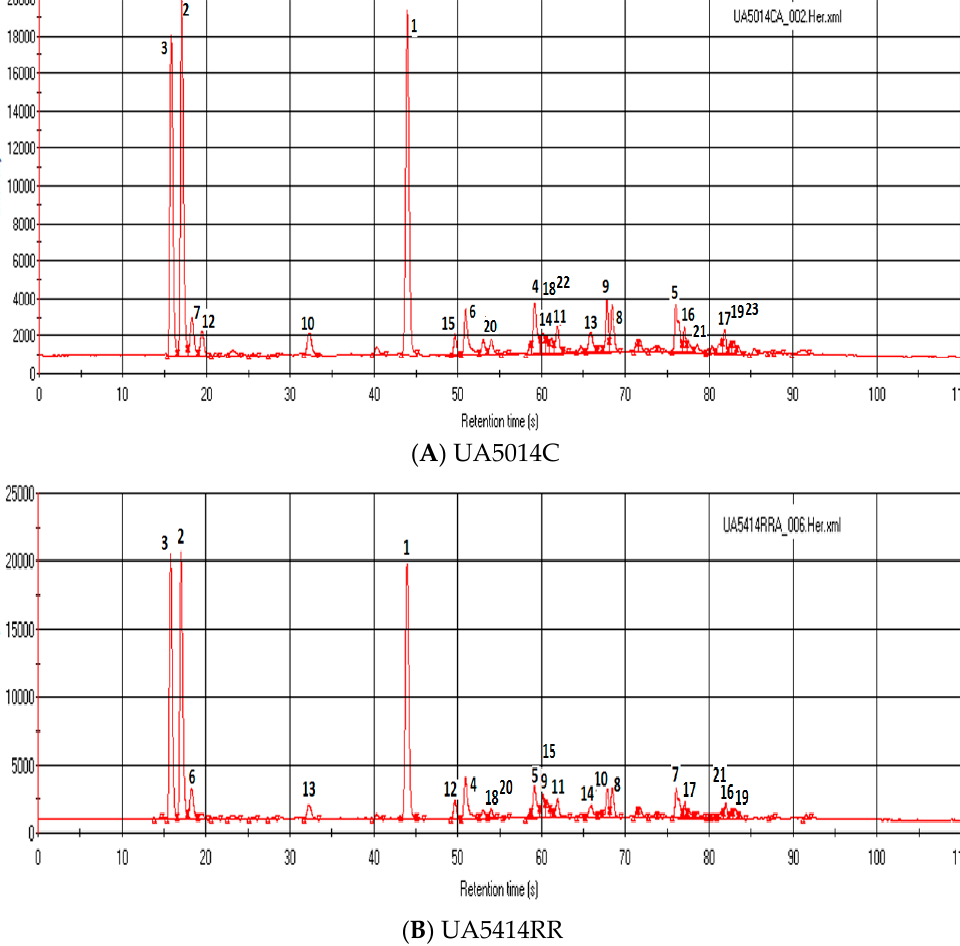
Figure 2. Ultra-fast GC Chromatogram of soybean varieties: UA5014C and UA5414RR.